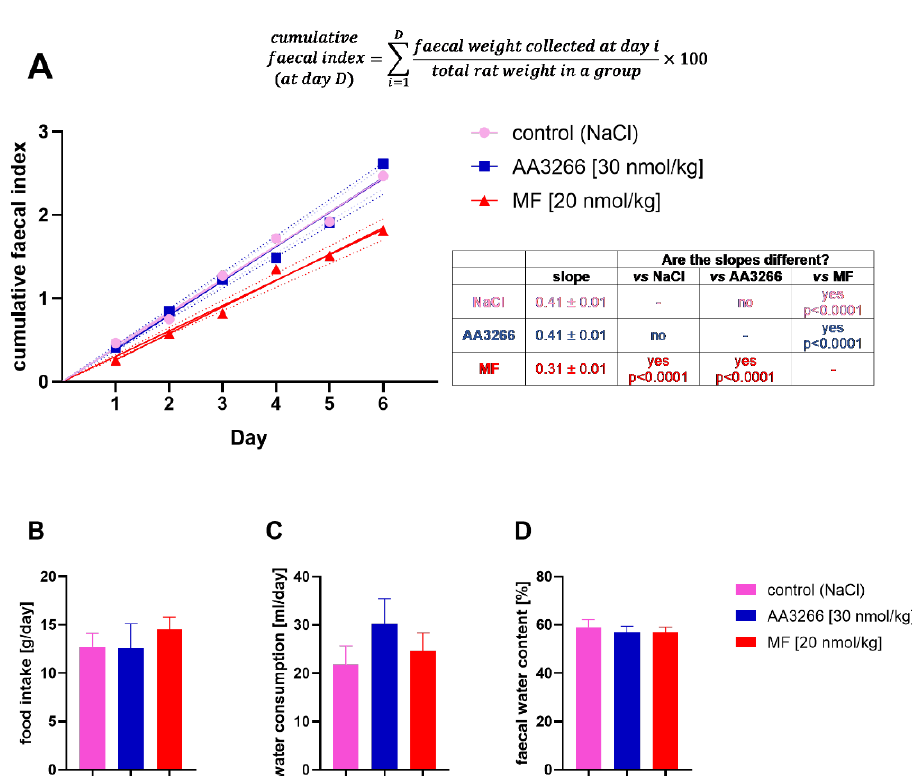
Figure 4. The influence of the prolonged administration of AA3266, MF and NaCl on ( A ) the cumulative faecal index, ( B ) food intake, ( C ) water consumption and ( D ) faecal water content. The line in the ( A ) subplot is a curve of linear relationship between the index and the experiment day. The dotted lines represent 95% confidence intervals of the linear curve. Whether the regression slopes are di ff erent for the groups, was tested with the extra sum-of-squares F test. In the subplots ( B – D ), the bars represent the mean over the 6 days with the standard error of the mean. For these data (food intake, water consumption and faecal water content), according to the one-way analysis of variance (ANOVA), there is no significant di ff erence between the means ( α =